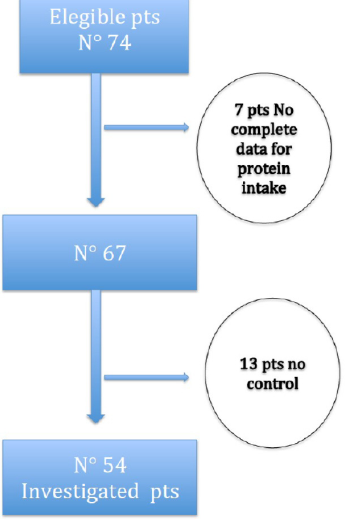
Figure 1. Flow chart of the study.